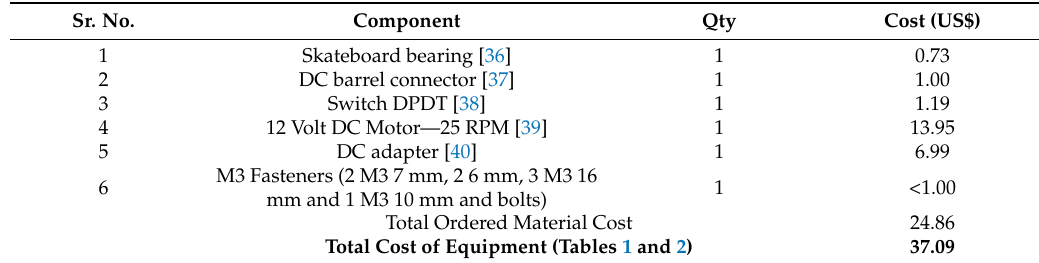
Table 2. BOM for ordered